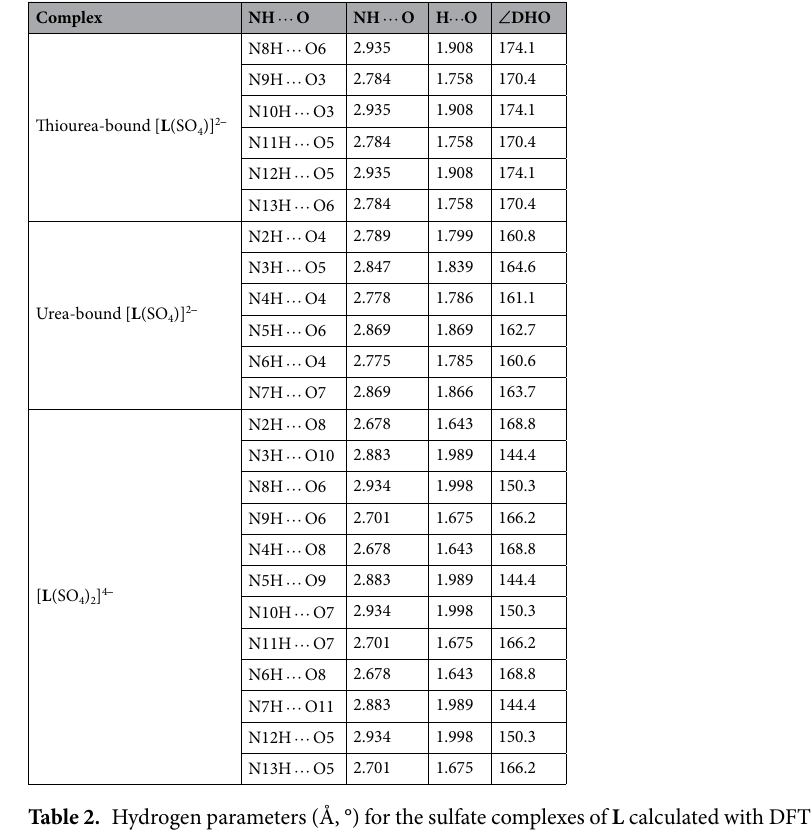
Table 2. Hydrogen parameters (Å, °) for the sulfate complexes of L calculated with DFT at